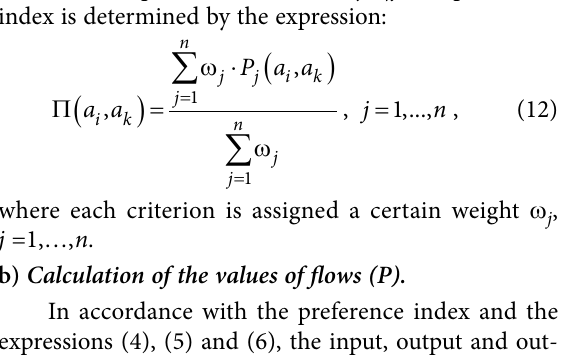
Fig. 3. Algorithm of the CRC